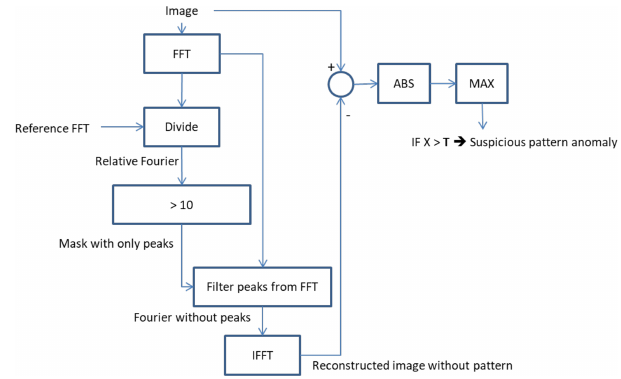
Figure 6. Conceptual processing pipeline for detecting the suspi- cious pattern